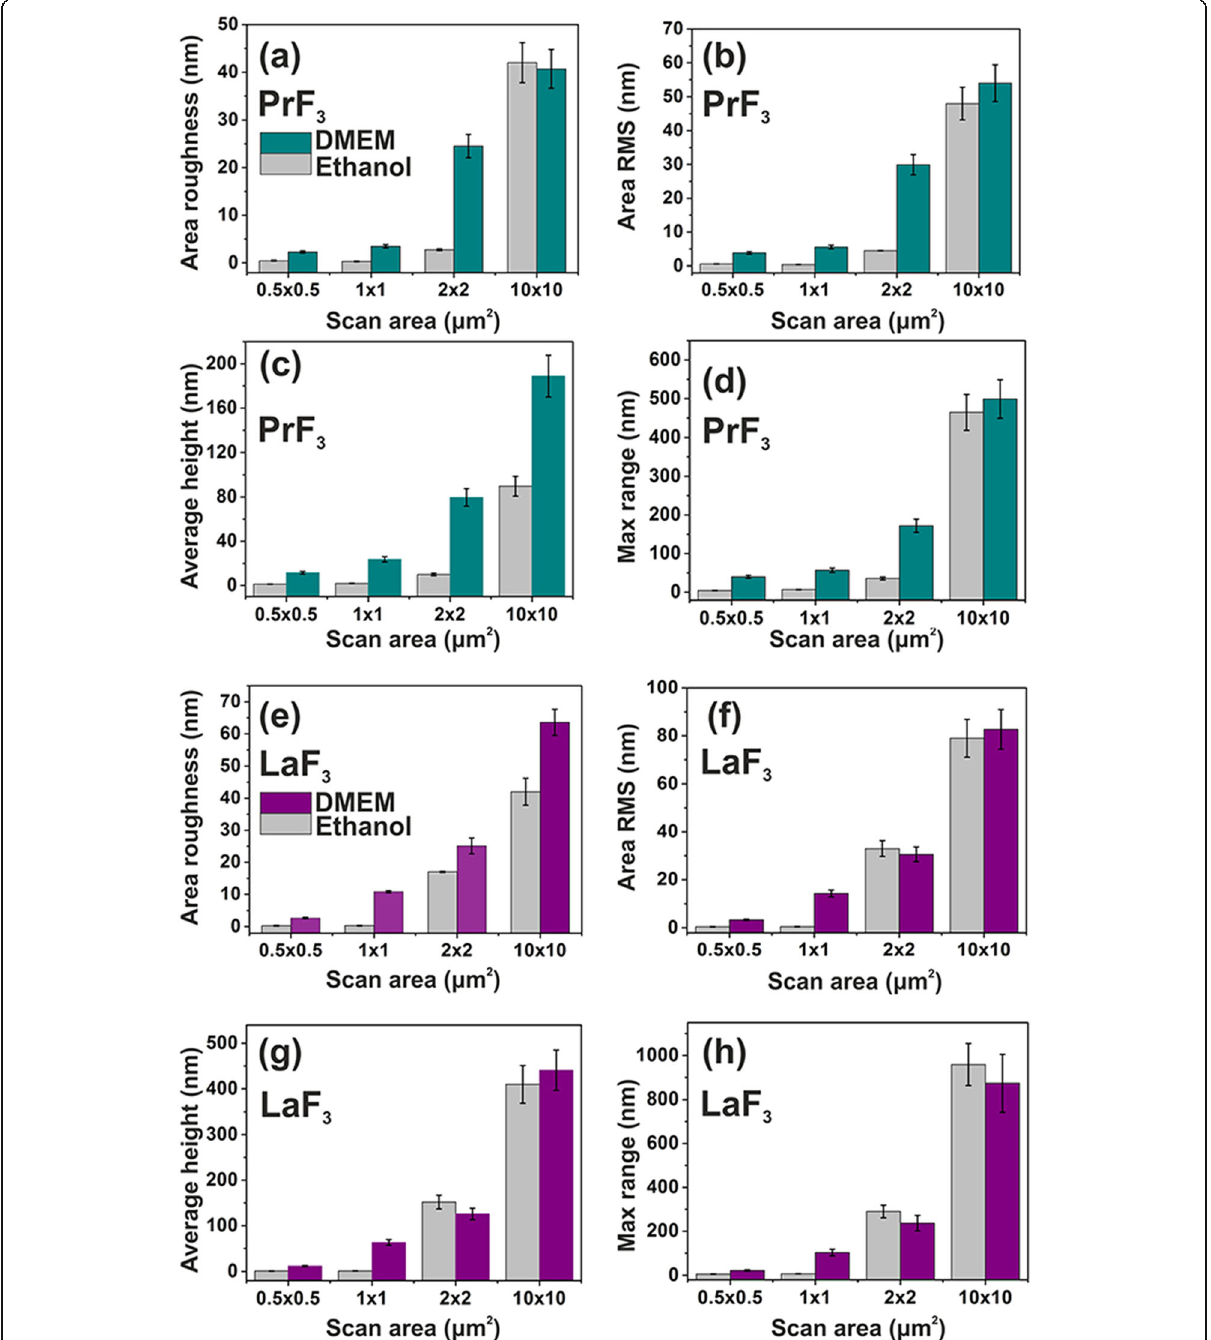
Fig. 4 Surface parameter histograms (z-height) of PrF 3 and LaF 3 RE-NPs on a glass substrate in DMEM+FBS and ethanol for different scanning areas. a , e Area roughness. b , f Area RMS. c , g Average height. d , h Maximum z